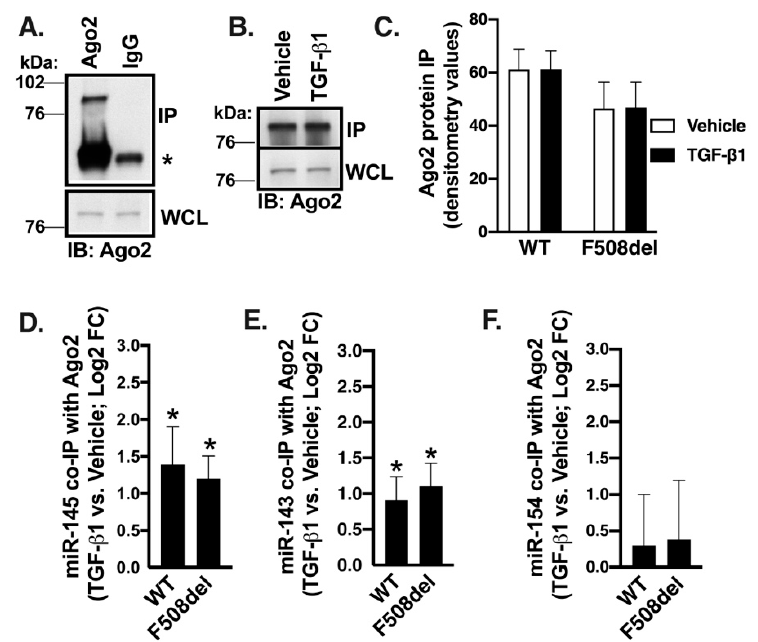
Figure 9. TGF- β 1 selectively recruited miRNAs validated or predicted as CFTR inhibitors to RISC in WT-and F508del-CFBE cells ( A ). Representative WB images showing that Ago2 was specifically immunoprecipitated (IP) with the anti-Ago2 antibody RN003M. Non-immune IgG was used as a negative control. Ago2 protein was detected in the IP and whole cell lysate (WCL) samples with the anti-Ago2 antibody. IP Ago2 was normalized for WCL Ago2. The non-specific band of the IP antibody is marked with an asterisk. Representative WB images ( B ) and summary of data ( C ) showing that TGF- β 1 had no e ff ect on Ago2 abundance in WCL and the Ago2 IP e ffi ciency in WT- and F508del-CFBE cells. ( D – F ). The co-IP of miRNAs with Ago2 IP was detected by qRT-PCR in the IP samples. Threshold cycle (Ct) values of miR-145 in vehicle-treated cells were subtracted from Ct values of miR-145 in TGF- β 1-treated cells to generate ∆ Cts. FC in miR-145 level between samples was determined using the equation 2 − ∆ C t and expressed as Log2 FC versus vehicle. TGF- β 1 increased the miR-145 ( D ) and miR-143 ( E ) co-IP with Ago2 in WT-CFBE and F508del-CFBE cells and did not a ff ect the co-IP of miR-154 ( F ). Error bars, S.E.M. N = 10 / group. * p <